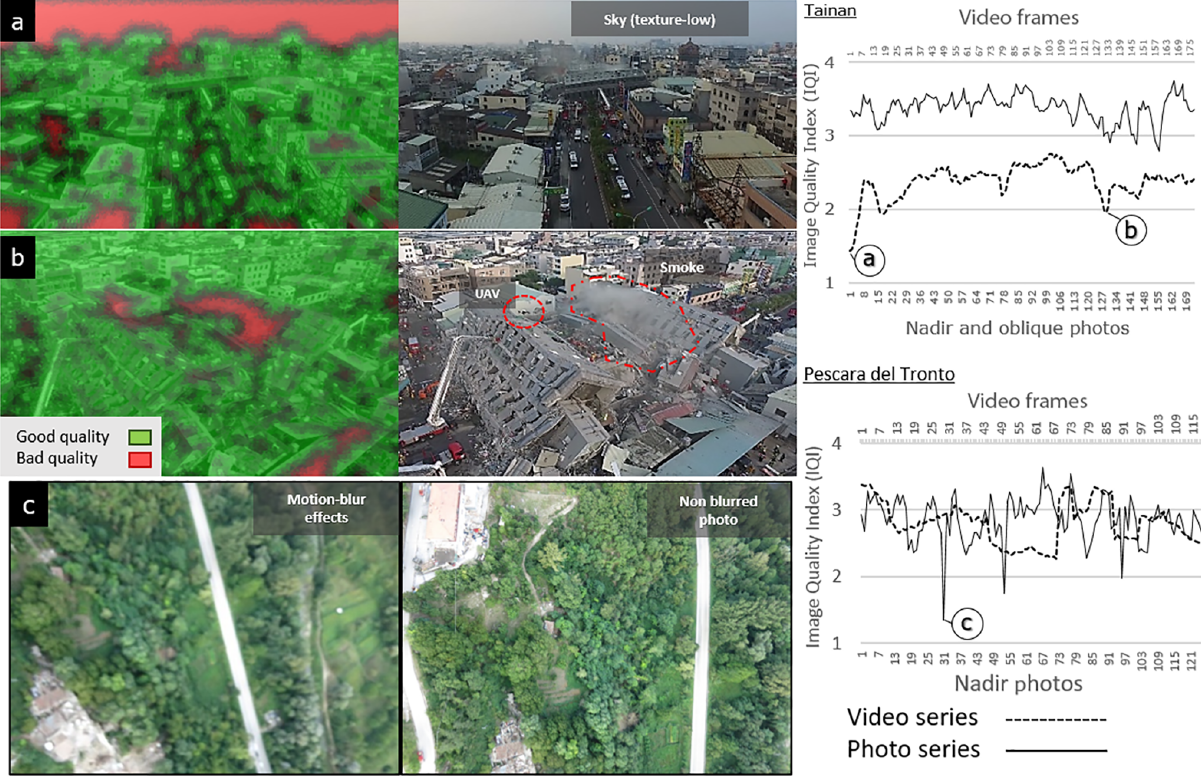
Figure 12. Image quality index (IQI) series for Pescara del Tronto and Tainan. (a) The sky as a low-texture area is considered a likely source of 3-D modeling error in IQI maps (red area). (b) Also smoke and moving objects (UAV). (c) In Pescara del Tronto motion-blur effects result in IQI